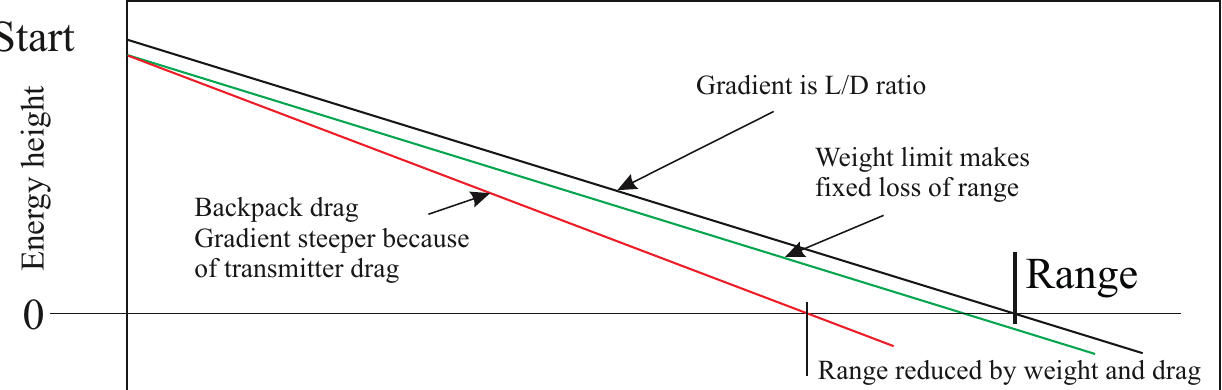
Figure 5. “Energy height” calculated from the fat fraction, represents the bird’s fuel ratio, but does not reflect the bird’s size. The “descent” from energy height in level flight is the same as the bird’s lift-to-drag ratio. Extra drag uses up fuel continuously during a long flight, while the weight of the box may limit the amount of fuel that can be taken up initially, but has little other effect. The increased drag due to an added box (red line) consumes fuel whenever the bird is flying.